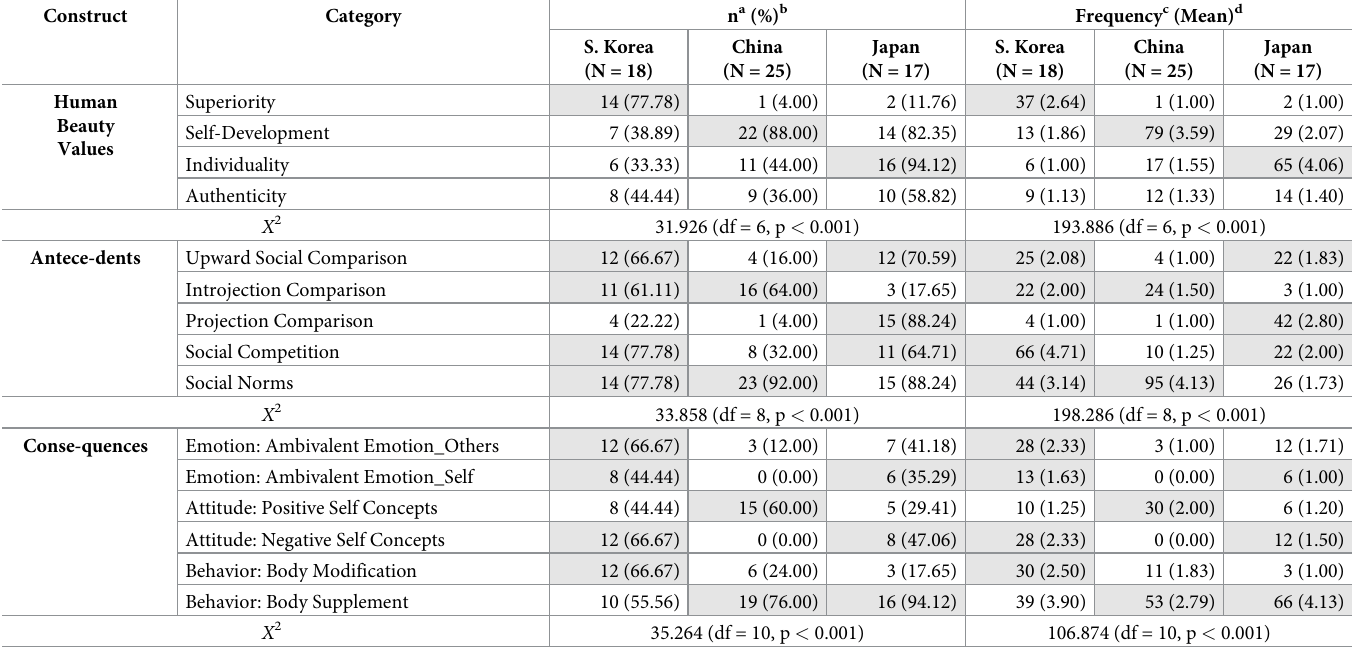
Table 4. Qualitative construct, category, and frequency.